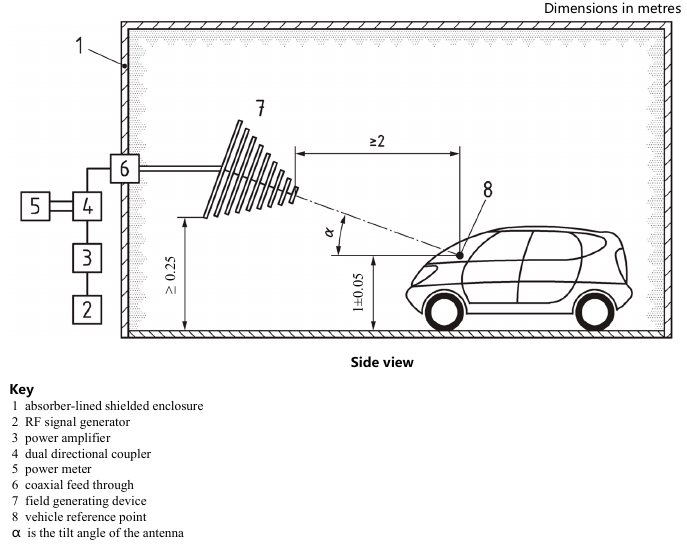
Figure 1. Typical setup of the whole-vehicle radiated immunity test according to ISO 11451-2.